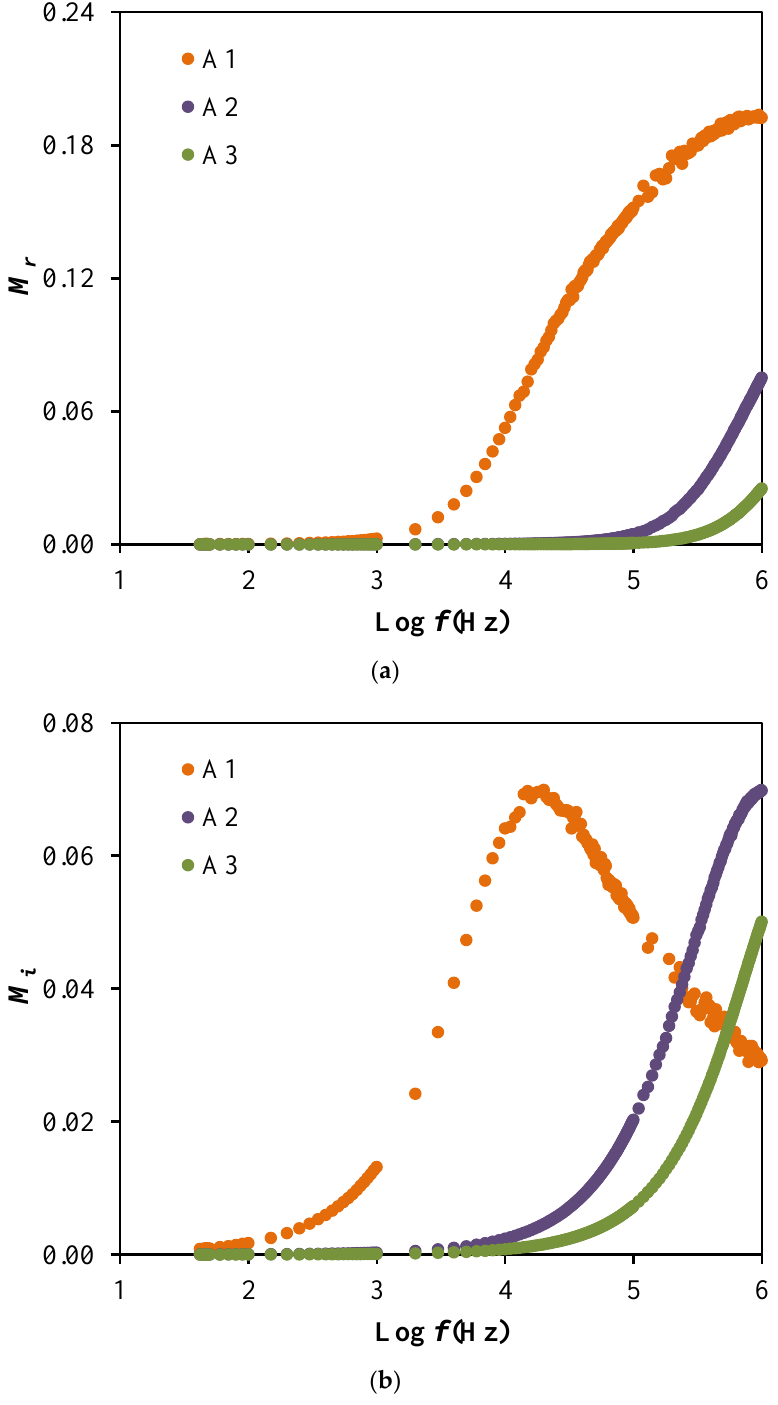
Figure 6. The plot of ( a ) M r and ( b ) M i for the electrolyte system.